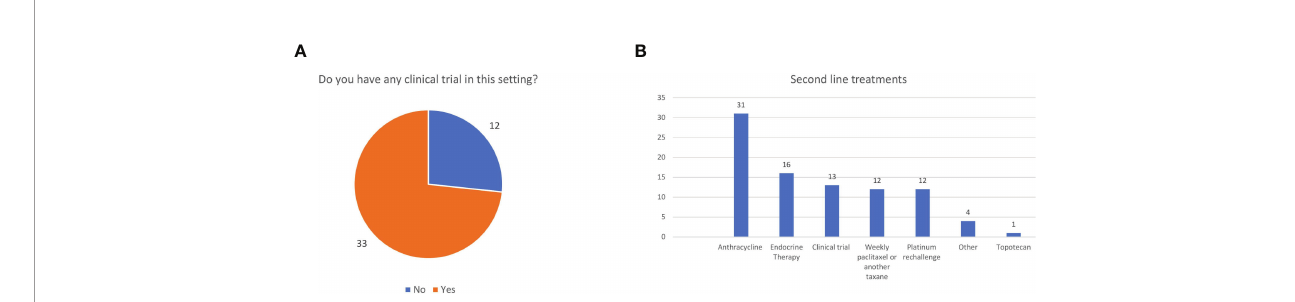
FIGURE 1 | Clinical trials (A) and treatment choices (B) in second